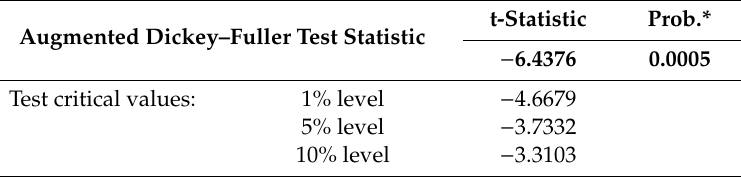
Table 8. Square root test of zero order di ff erential of MGM relative